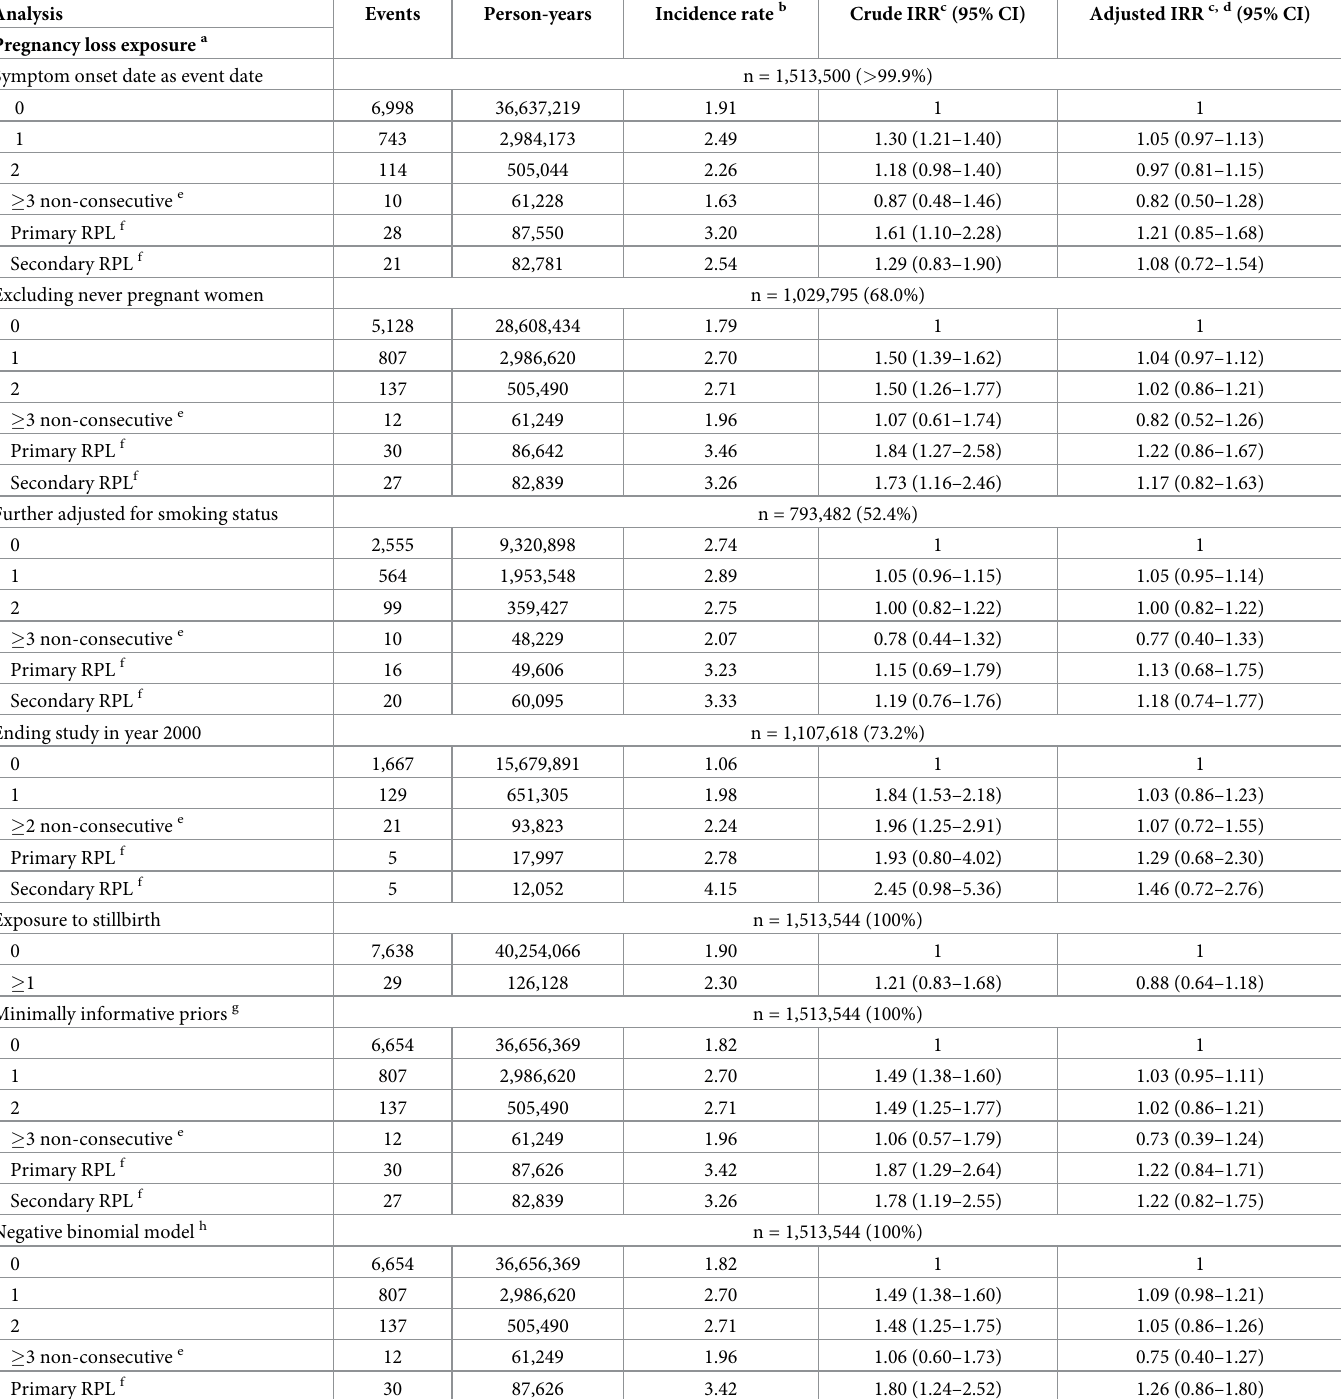
Table 2. Association of pregnancy loss with multiple sclerosis, sensitivity